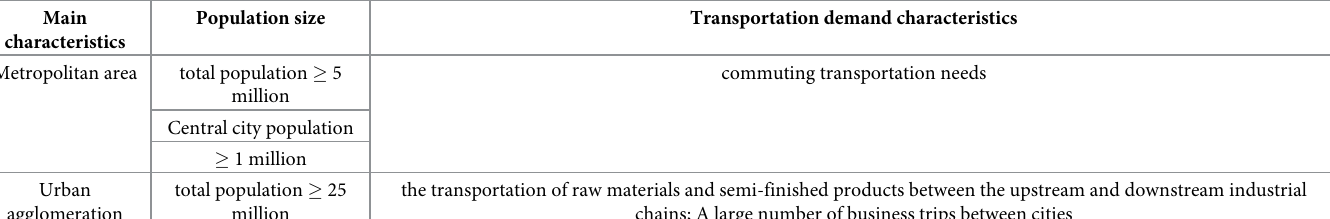
Table 1. Comparison of population and traffic demand characteristics between metropolitan areas and urban agglomerations.